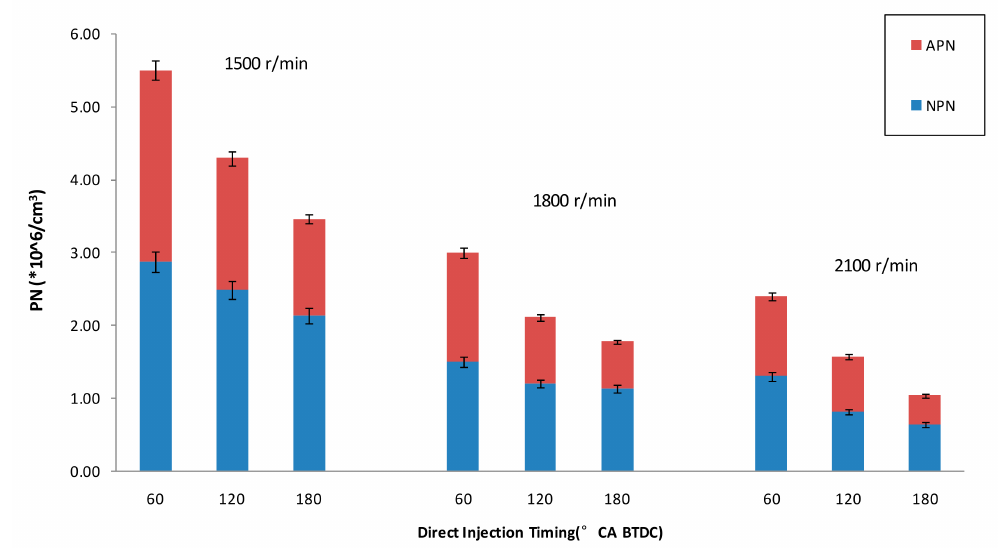
Figure 12. Particle number with direct injection timing for di ff erent speed (The ignition timing is MBT at G25 and the intake manifold absolute pressure is 42